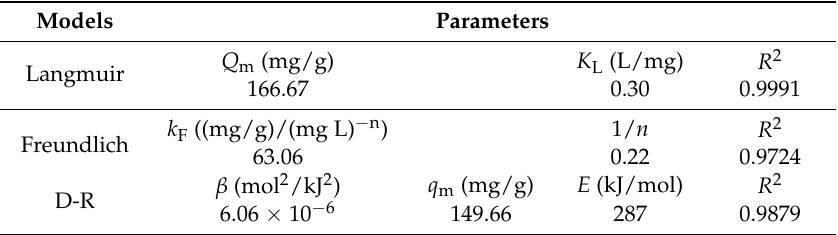
Table 1. Isotherm parameters of the Langmuir, Freundlich, and D-R models.